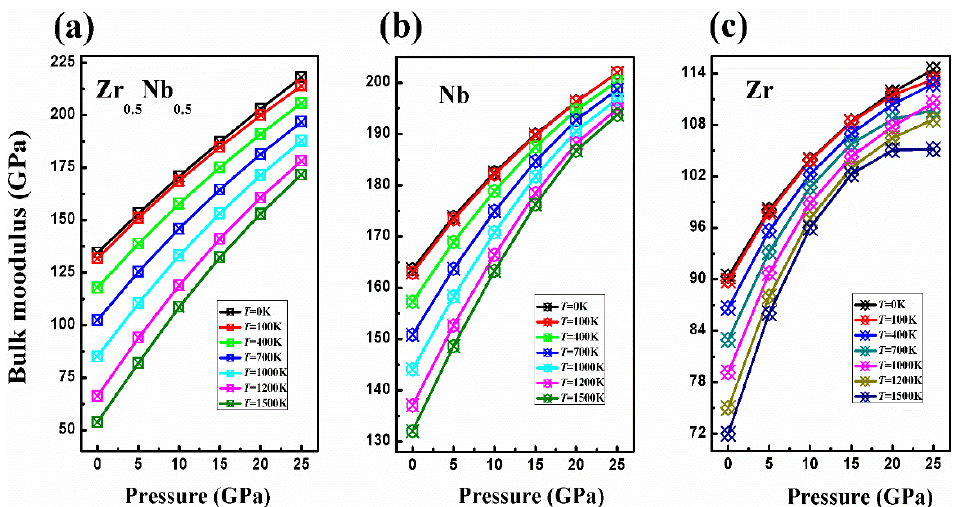
Figure 5. Predicted bulk modulus for cubic Zr 0.5 Nb 0.5 at high pressure and high temperature ( a ), in comparison with those for Nb ( b ) and hcp -Zr ( c ) metals.